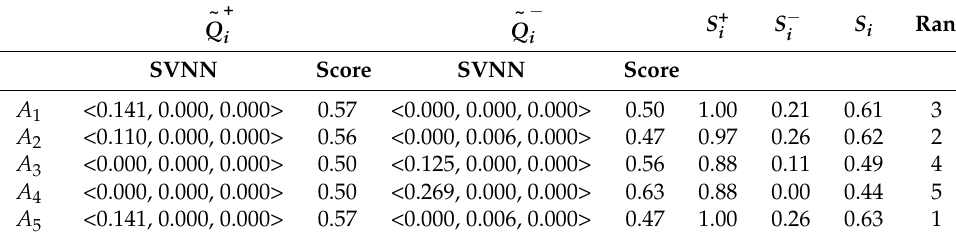
Table 19. Computational details and ranking order of considered